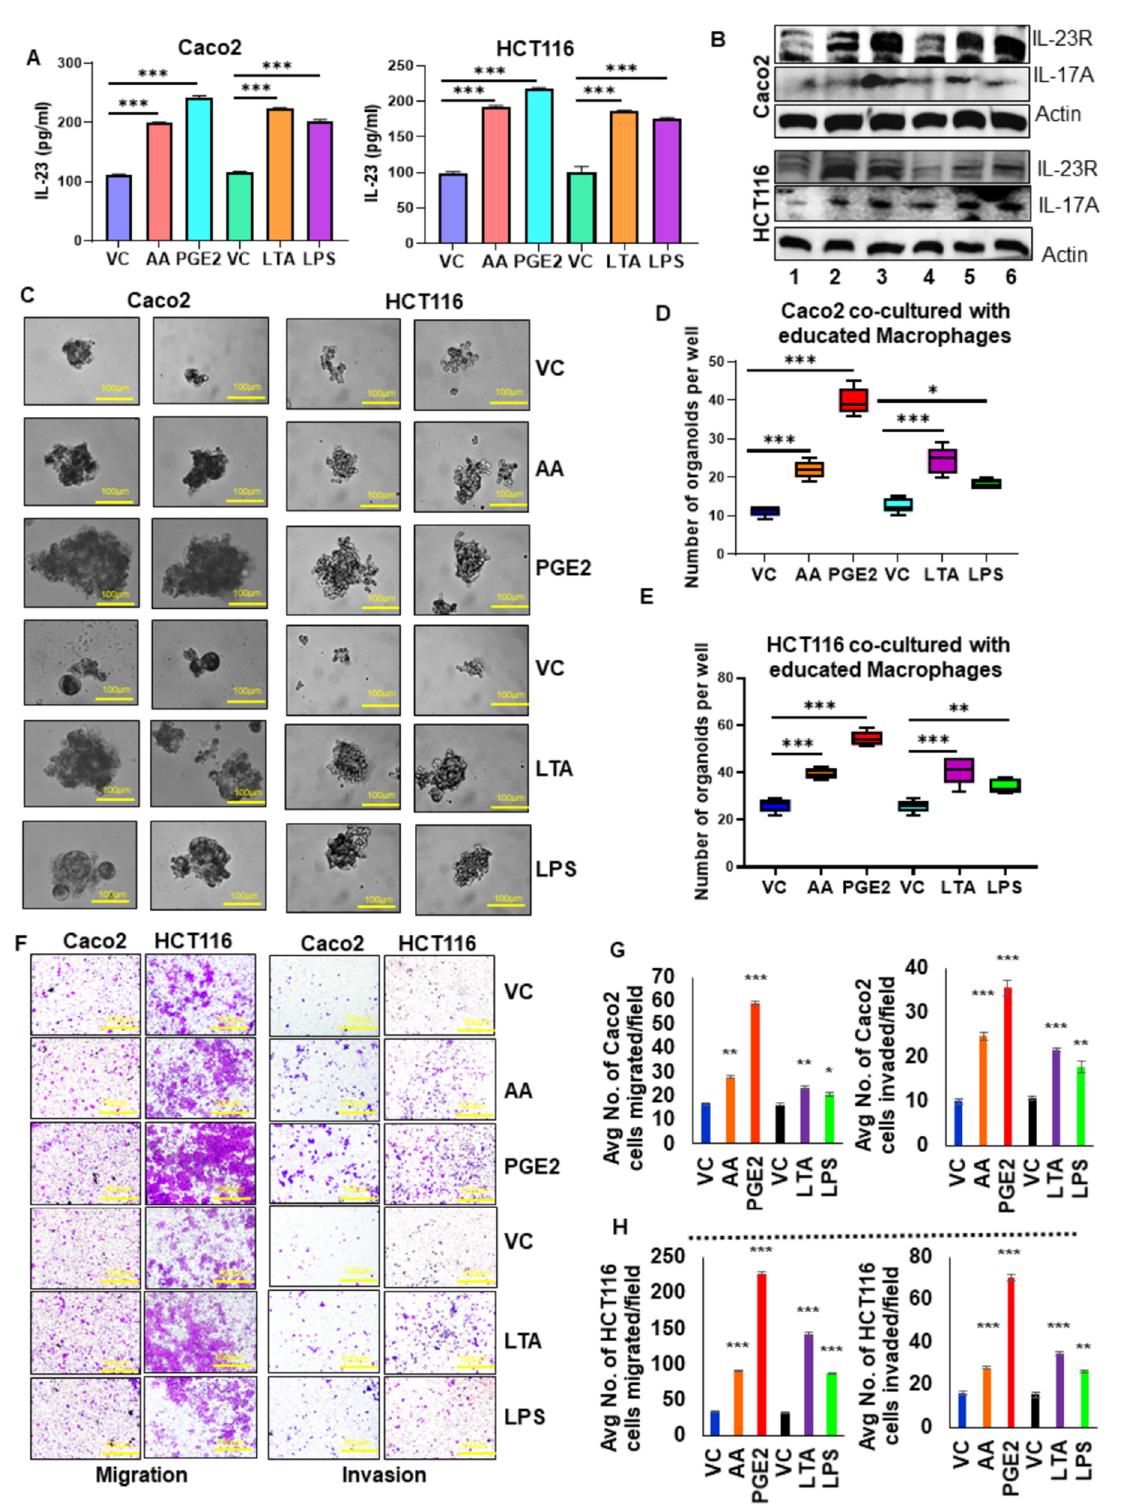
Figure 5. IL-23 production by macrophages enhances colon tumor cell aggressiveness. ( A ) The level of IL-23 in the spent media of the co-culture system (Caco2/HCT116 + educated macrophages with AA/PGE 2 /LTA/LPS) was measured using ELISA. ( B ) The expression of IL-23R, IL-17A were analyzed in Caco2 and HCT116 cells co-cultured with educated macrophages compared to uneducated macrophages. Lane1-Vehicle control, Lane2-AA, Lane3- PGE 2 , Lane4- Vehicle control, Lane5- LTA, Lane6- LPS. β -actin was used as a protein loading control. ( C ) Co-culture of educated macrophages with tumor cells increased the self-renewal ability of cancer cells compared with uneducated macrophages co-culture system (Magnification 40×). ( D , E ) Quantification of organoids formed by tumor cells co-cultured with educated macrophages